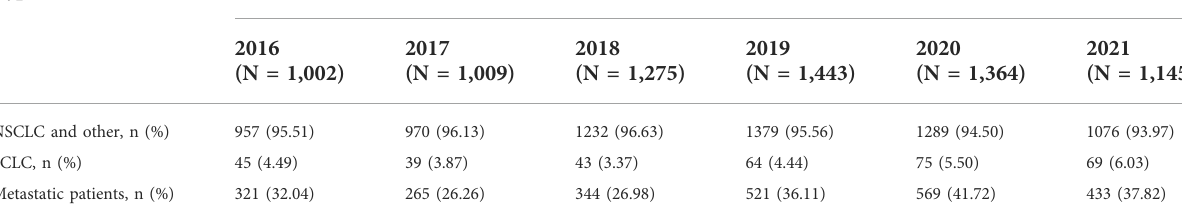
TABLE 2 The prevalence of type and metastatic in elderly lung cancer outpatients with multimorbidity. Type